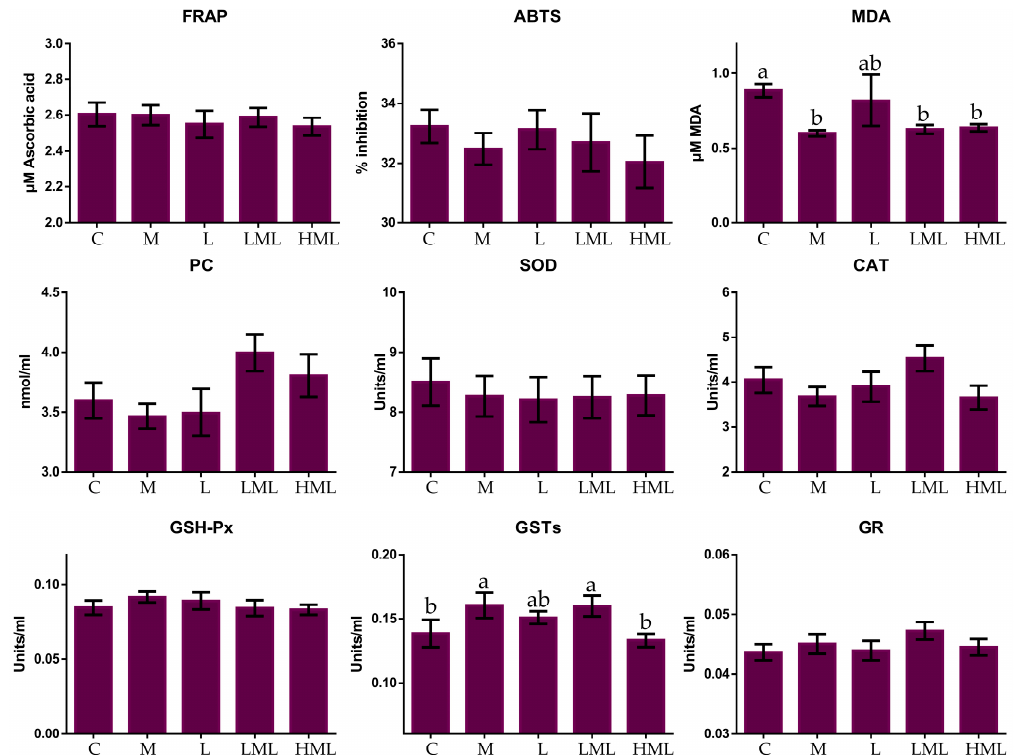
Figure 2. Means ± SEM of total antioxidant capacity, oxidative stress indicators, and enzyme activities (Units/mL), in the blood plasma of ewes, fed the five diets (C, M, L, LML, and HML) within the three sampling times. Bars with different superscript (a, b) between dietary treatments differ significantly ( p ≤ 0.05).